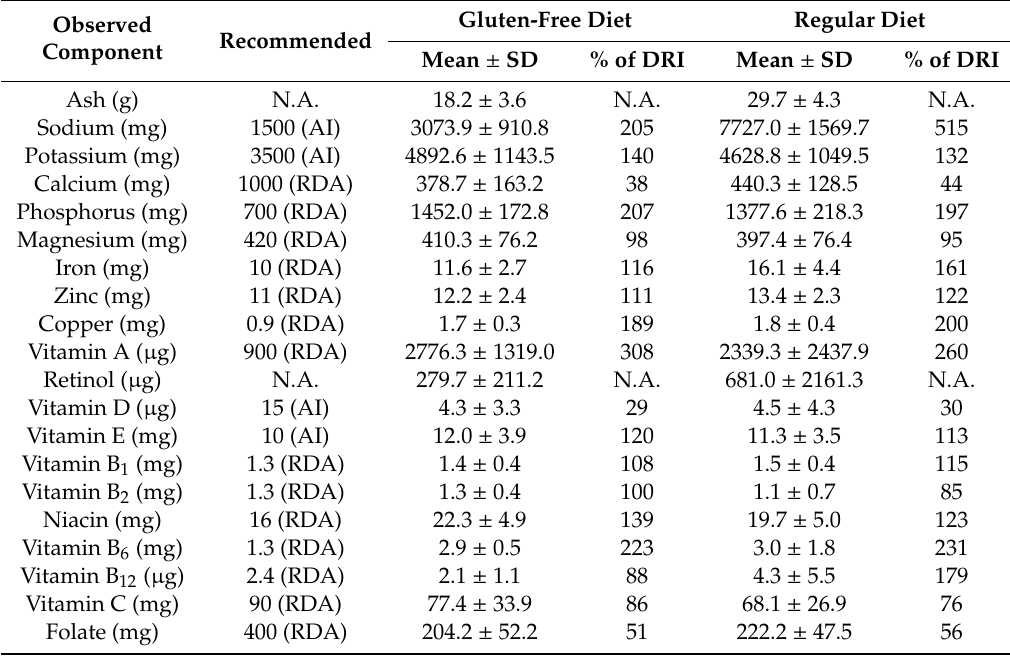
Table 2. Micronutrients provided in prisons ( n = 10) menus per person per day and the age-specific dietary reference intake